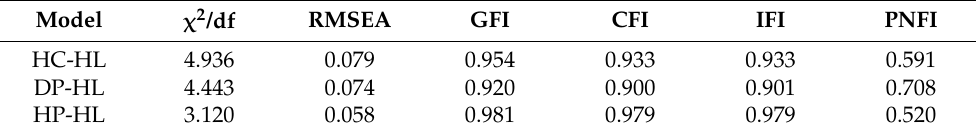
Table 5. Construct validity of CPHLQ-Psychological Part.